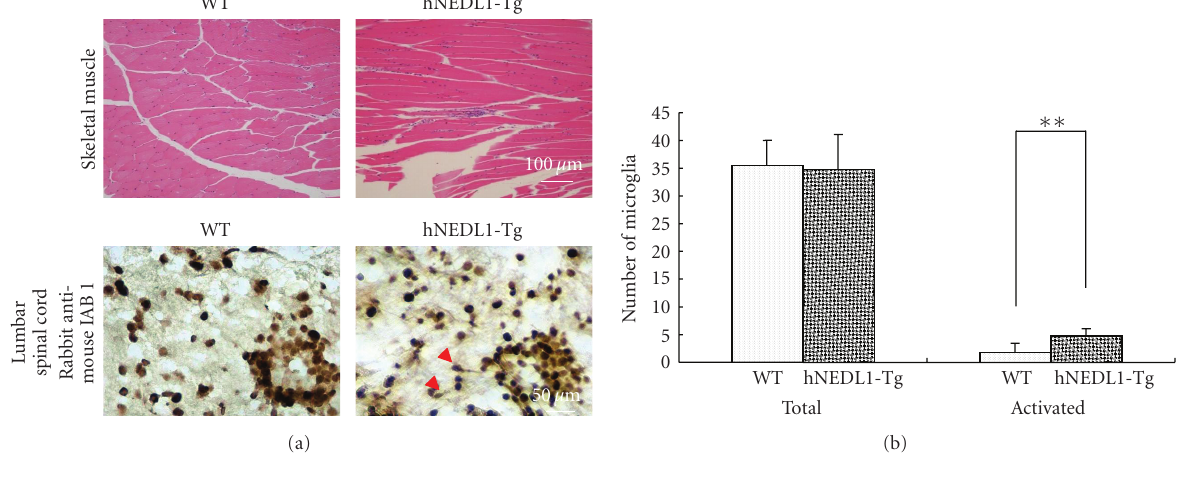
Figure 5: Overexpression of hNEDL1 induced neuron degeneration in lumbar spinal cord and skeletal muscle atrophy. (a) Haematoxylin and eosin-stained section of skeletal muscle from 6-month-old wild-type and hNEDL1-Tg mice (bar = 100 μ m). Muscle atrophy is observed in the hNEDL1-Tg mouse. (b) Immunochemistry study, by using Iba-1 antibody, represented the microglia cells in spinal cord tissue. The numbers of total microglia cells and the activated microglia cells, which were judged by the morphologic change, were counted.